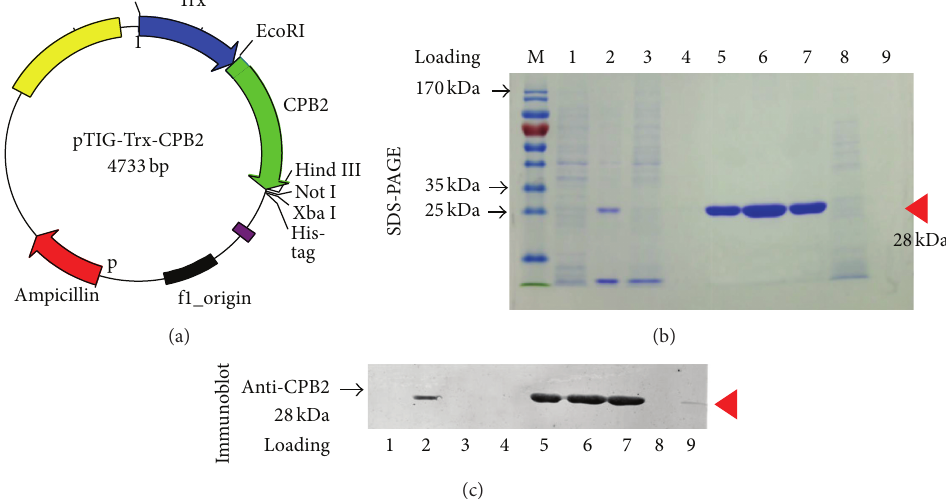
Figure 1: Purification and characterization of recombinant toxin beta2 of Clostridium perfringens type C (rCPB2). The expression of CPB2 was induced by IPTG in E. coli BL21(DE3) cells harboring His-tagged CPB2 expressing plasmid pTIG-Trx-CPB2; the bacterial cells expressed rCPB2 lysed by sonication, and the soluble fraction of cells was used for purification of rCPB2 by HPLC AKTA PURIFIER PH/C10 system using a Ni-NTA column with a linear gradient elution of 0–1000 mM imidazole. (a) The map of pTIG-Trx-CPB2 plasmid capable of expressing rCPB2 in E. coli cells. (b) An image of the expression and purification of recombinant CPB by a Coomassie stained SDS-PAGE (12%) analysis. Lane M , a ladder of molecular weights (MW). Lane 1, a lysate of E. coli BL21(DE3) cells transformed with plasmid pTIG-Trx. Lane 2, a lysate of E. coli BL21 (DE3) cells transformed with plasmid pTIG-Trx-CPB2 induced by IPTG. Lane 3, a fraction of HPLC elution at 10mM of imidazole. Lane 4, a fraction of HPLC elution at 25 mM of imidazole. Lanes 5–7, fractions of HPLC elution at 75 mM of imidazole. Lane 8, cell lysate of C59-44. Lane 9 , the culture supernatant of C59-44 (type C). A band of protein of interest with expected MW of ∼ 28 kDa was observed in lanes 2 and 5–7 (arrowhead). (c) An immunoblotting analysis of the specificity and integrity of purified rCPB2 using monoclonal antibody against CPB2; a specific band was detected in purified fractions of rCPB2 (lanes 5–7); the lysate of E. coli harboring cpb2 recombinant plasmid (lane 2) and supernatant of C. perfringens C59-44 strain (lane